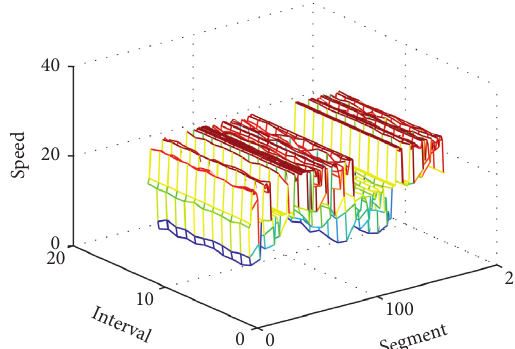
Figure 12: The averaged speed with control.